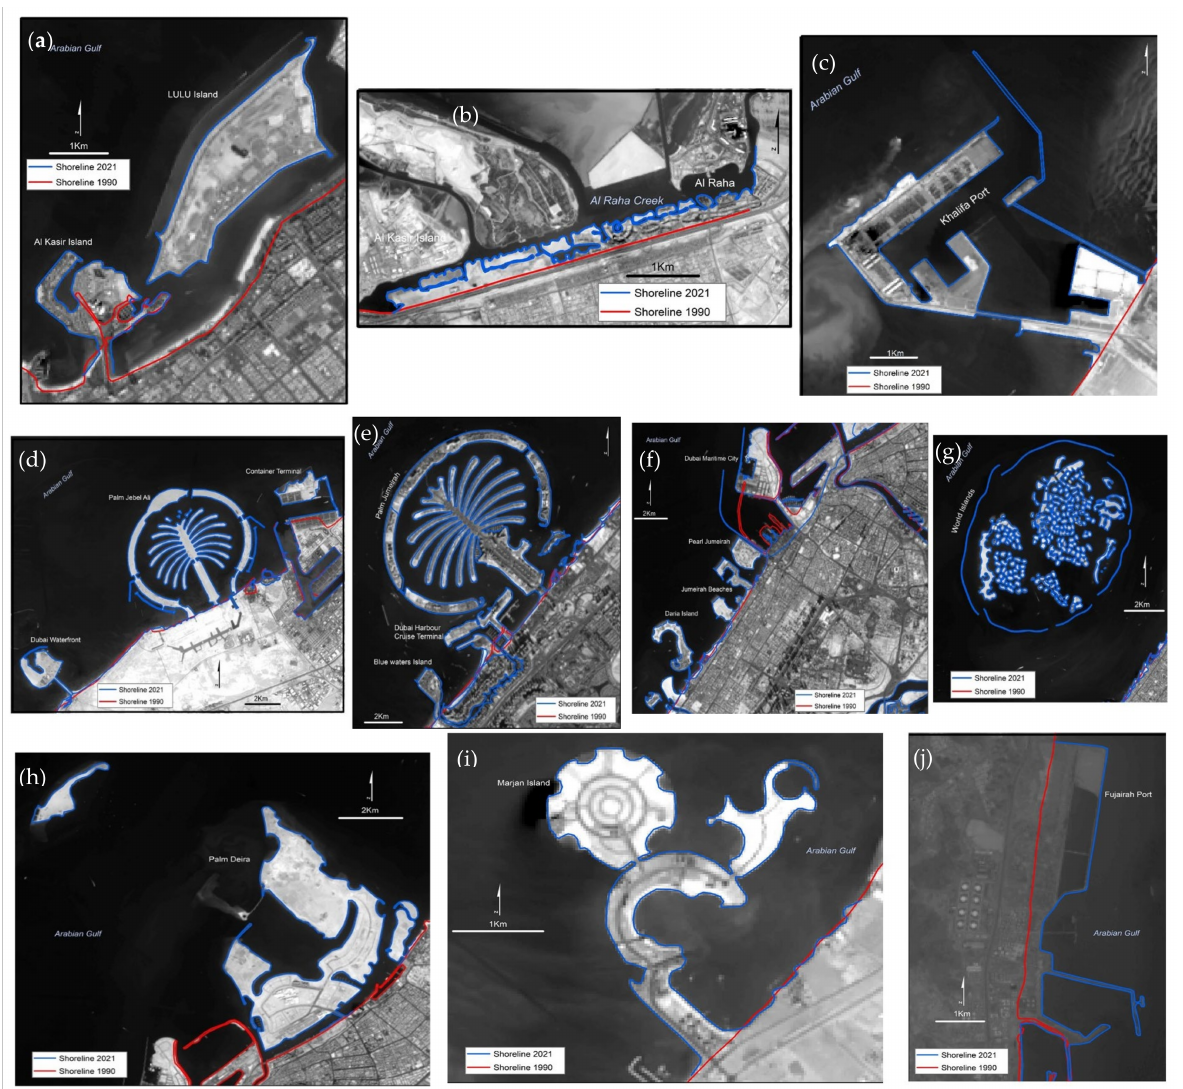
Figure 5. Artificial reclamation of land in Abu Dhabi ( a – c ); Dubai ( d – h ); RAK ( i ); Fujairah ( j ).